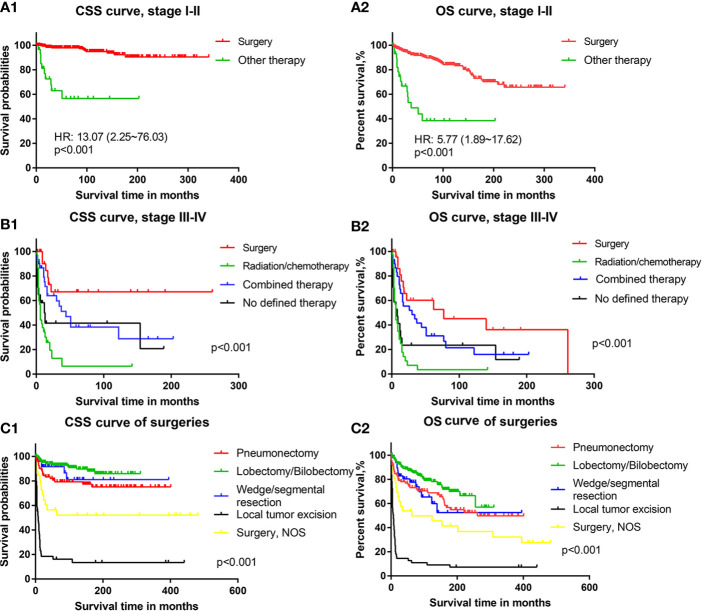
The cancer-specific survival and overall survival of patients with different treatments: (A1) Cancer-specific survival of PMEC patients in TNM stages I–II with surgery or other therapy. (A2) Overall survival of PMEC patients in TNM stages I–II with surgery or other therapy. (B1) Cancer-specific survival of PMEC patients in TNM stages III–IV with surgery, radiation/chemotherapy, combined therapy and no defined therapy. (B2) Overall survival of PMEC patients in TNM stages III–IV with surgery, radiation/chemotherapy, combined therapy and no defined therapy. (C1) Cancer-specific survival of PMEC patients with pneumonectomy, lobectomy/bilobectomy, wedge/segmental resection and local tumor excision. (C2) Overall survival of PMEC patients with pneumonectomy, lobectomy/bilobectomy, wedge/segmental resection and local tumor excision.